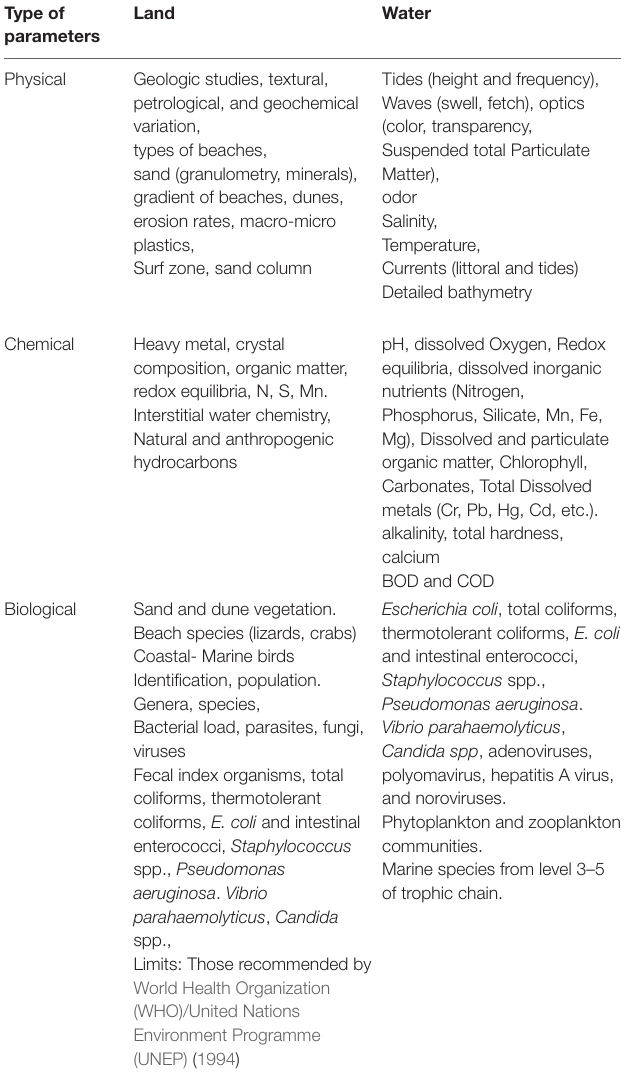
TABLE 3 | Parameters to be measured to create a data baseline for coastal zone management. Type of